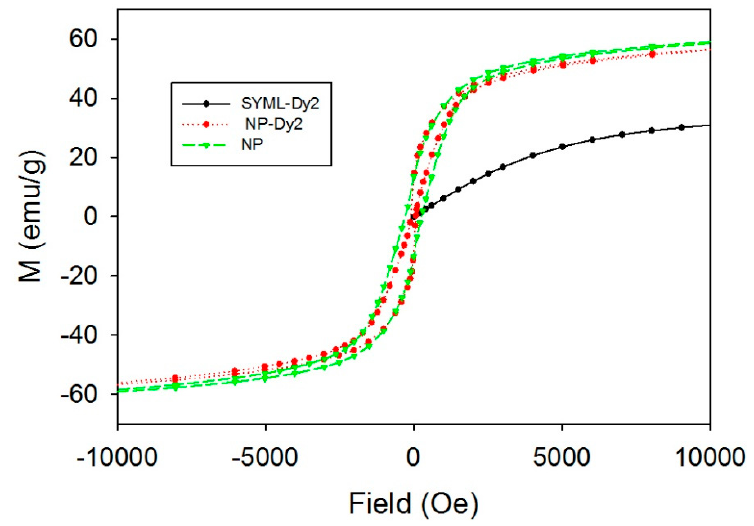
Figure 7. Hysteresis of the magnetization vs the applied field for NP, NP-Dy2 and magnetization vs. field for the complex SYML-Dy2 shown in emu/g at 2 K.